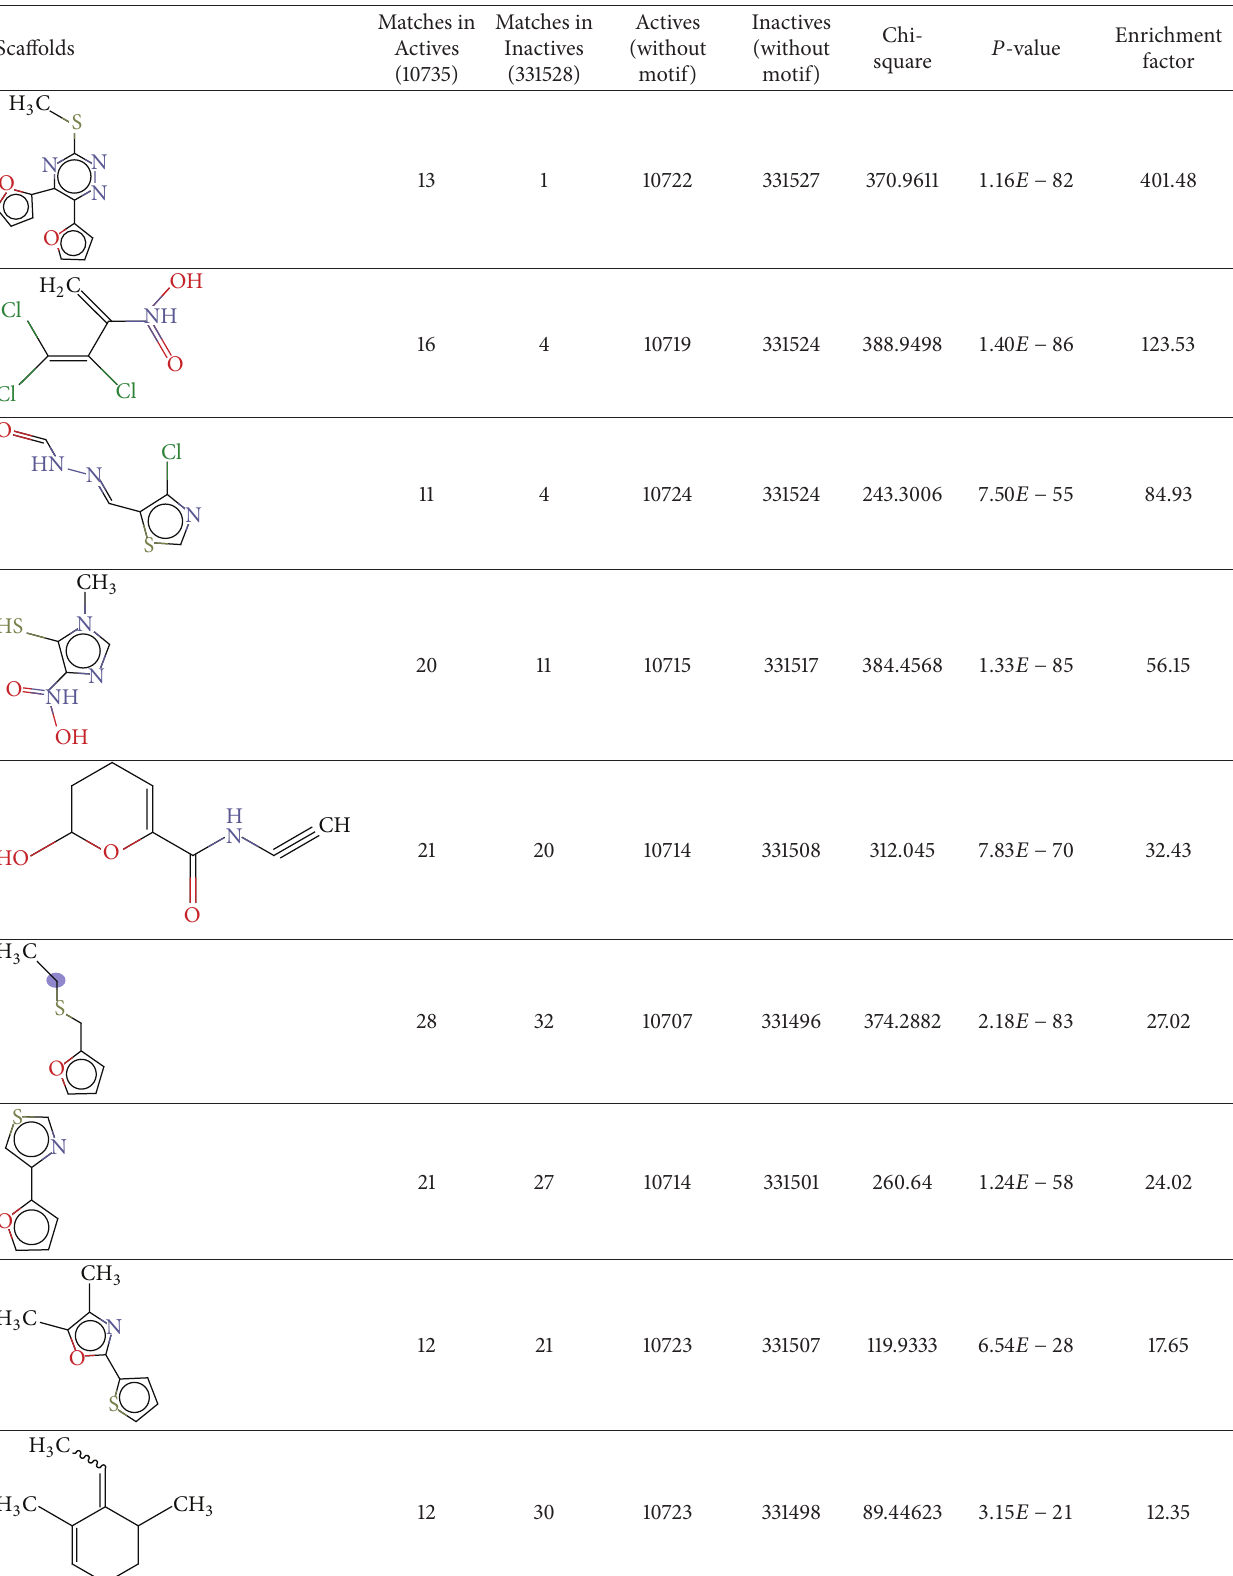
Table 2: The Enriched scaffolds having 𝑃 < 0.01 and enrichment factor > 10 that are corresponding to 184 actives. Matches Scaffolds